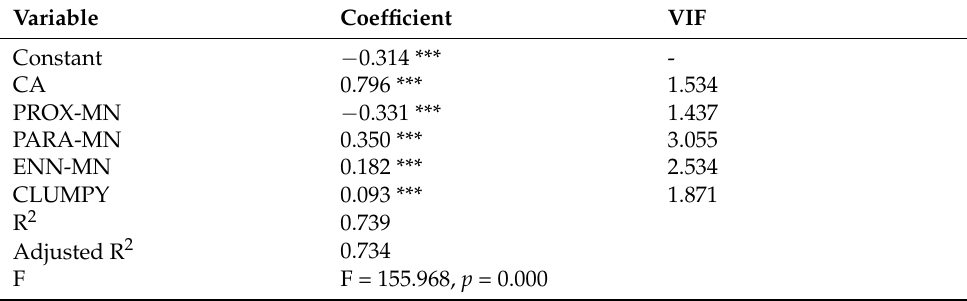
Table 2. Stepwise linear regression model results statistics.